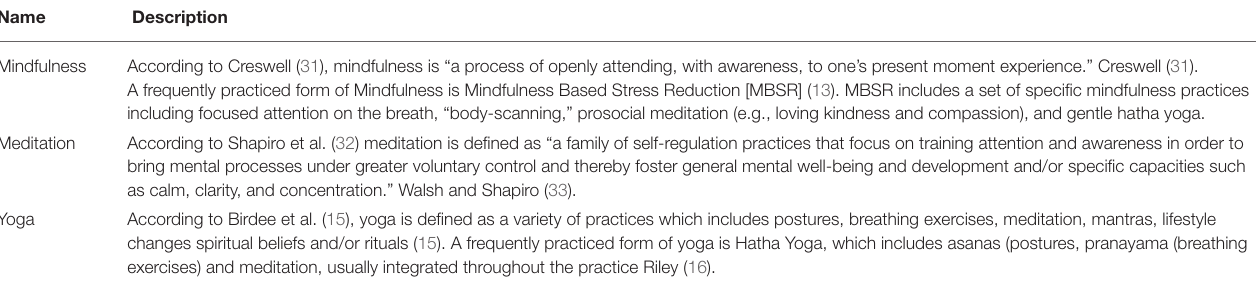
TABLE 1 | Definitions of intervention